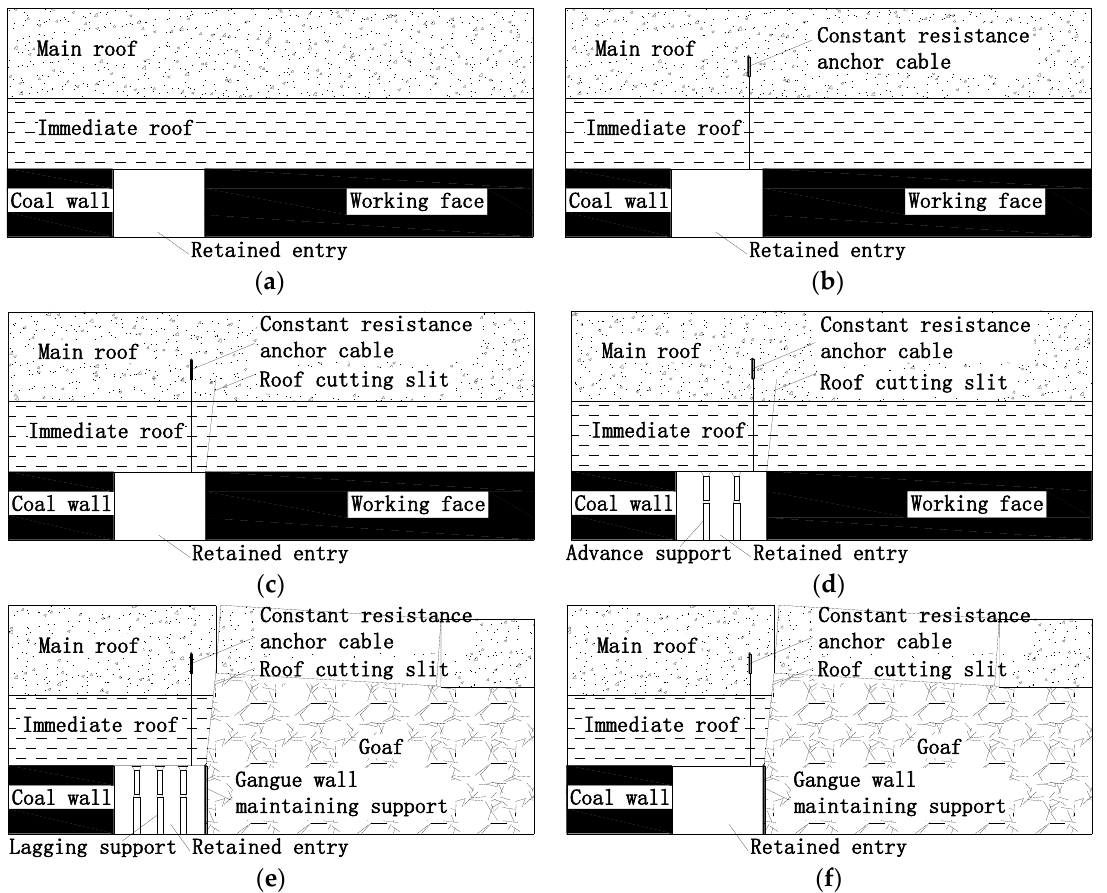
Figure 2. Technological process of the gob-side entry retention by roof cutting (GERRC) technique: ( a ) Entry excavation; ( b ) Support reinforcement; ( c ) Roof cutting; ( d ) Advanced temporary support; ( e ) Temporary support behind the working face and gangue wall maintaining support; ( f ) Retained entry.